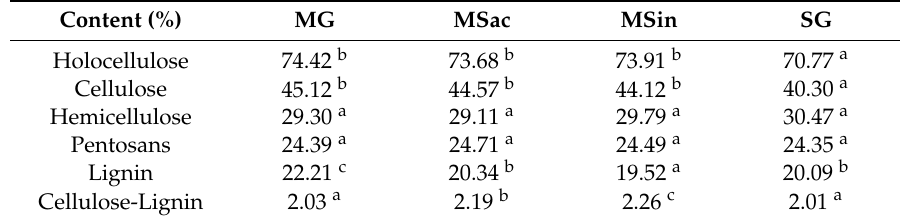
Table 2. Contents of main components of studied lignocellulosic raw materials. Significant di ff erences between materials are marked by letter indexes, separately for each component.